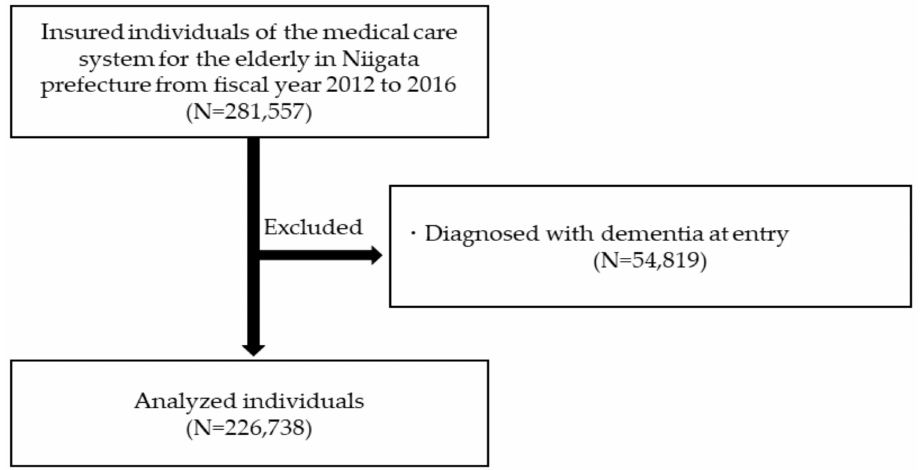
Figure 1. Flowchart of participant